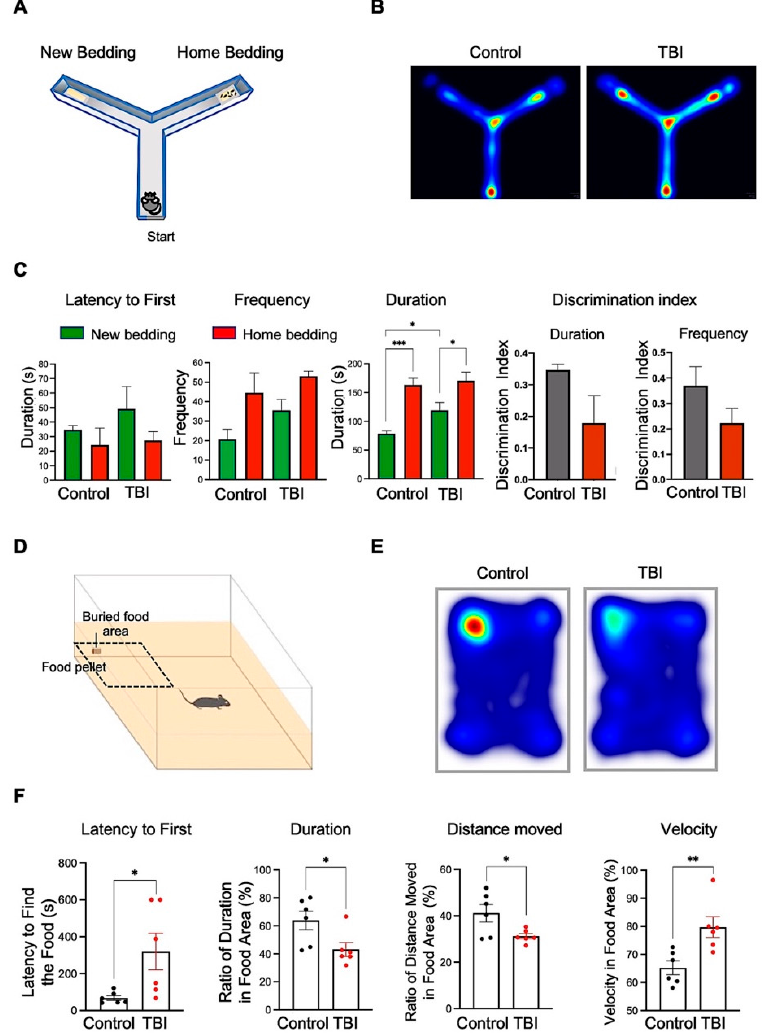
Figure 8. Repetitive TBI reduces olfactory-function-associated behaviors in home bedding and buried-food-seeking tests. ( A ) A scheme for Y maze apparatus and placement of new bedding and home bedding. ( B ) A representative heat map of Y maze trials shows an increased frequency in TBI mice in the arm with new bedding. ( C ) Control and TBI mice display alterations of latency to first,